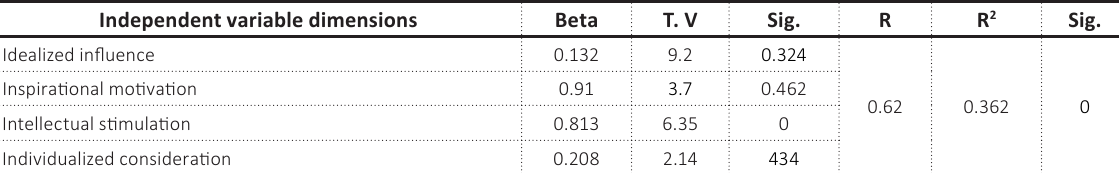
Table 5. Relationship between transformational leadership dimensions and internal work